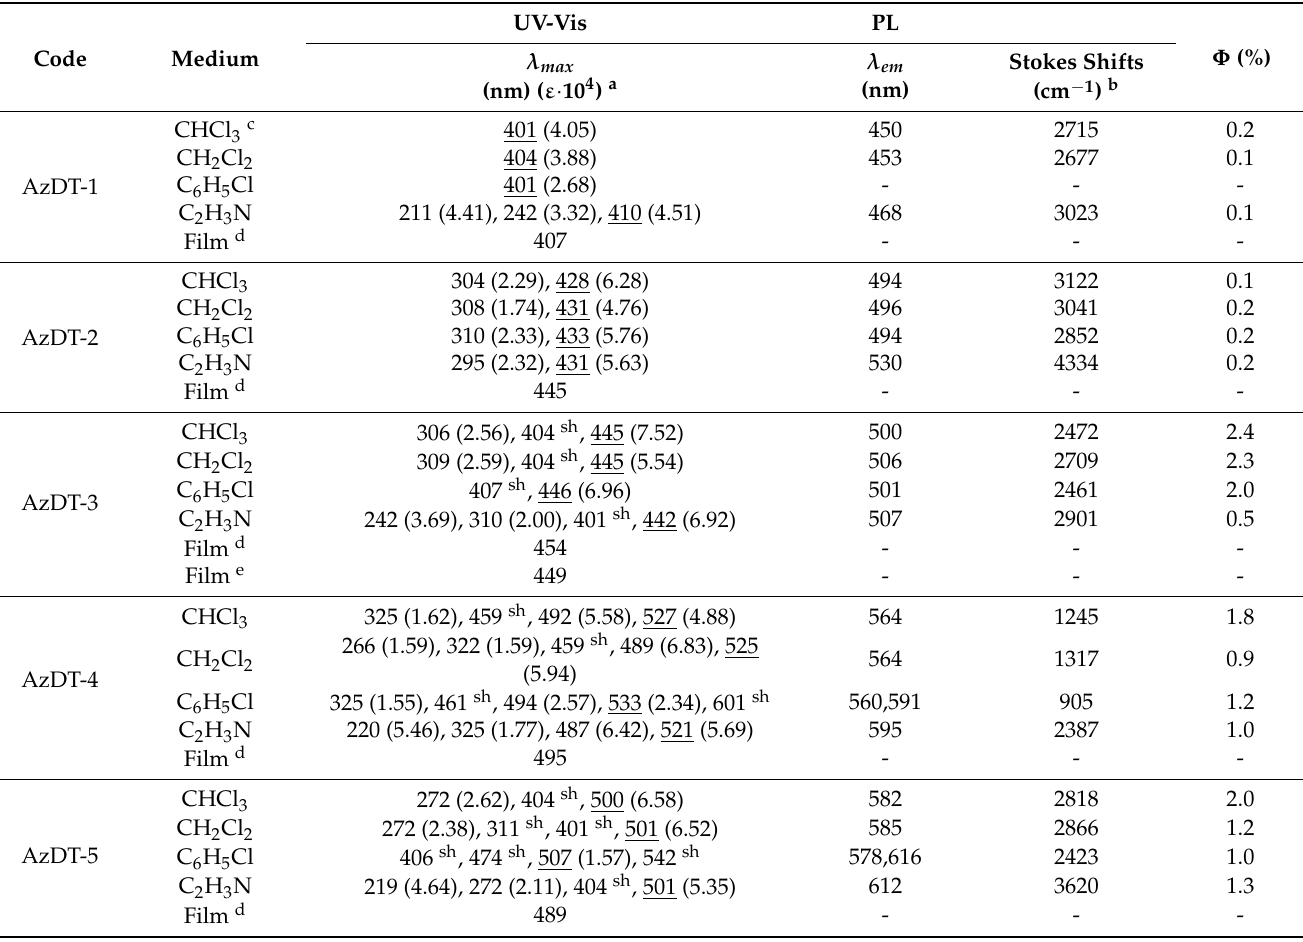
(649 nm, corresponding to the lower energy emission band cf. Table 3), the vertical emission from T 1 is only 0.42 eV. Table 3. UV-Vis and PL data of